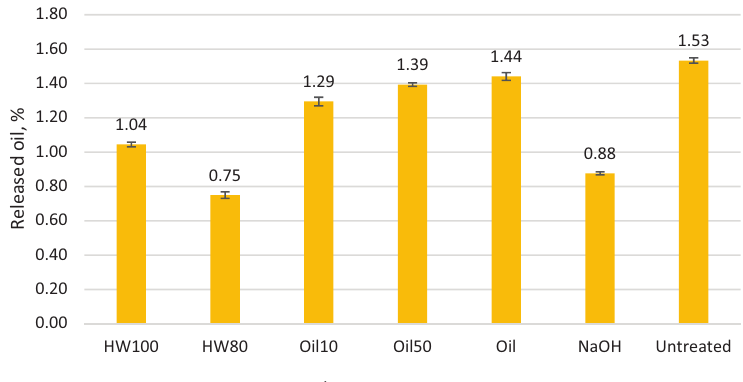
Figure 6. Results of dieselretention